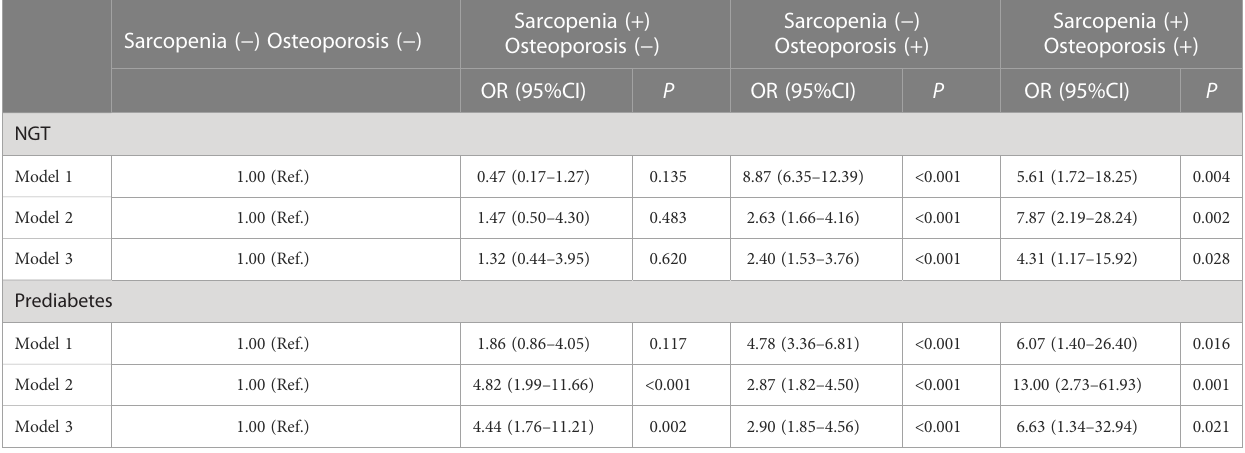
TABLE 5 Incidence rate ratios (95% CI) for spine fracture according to categories based on sarcopenia and osteoporosis in NGT/prediabetes adults.